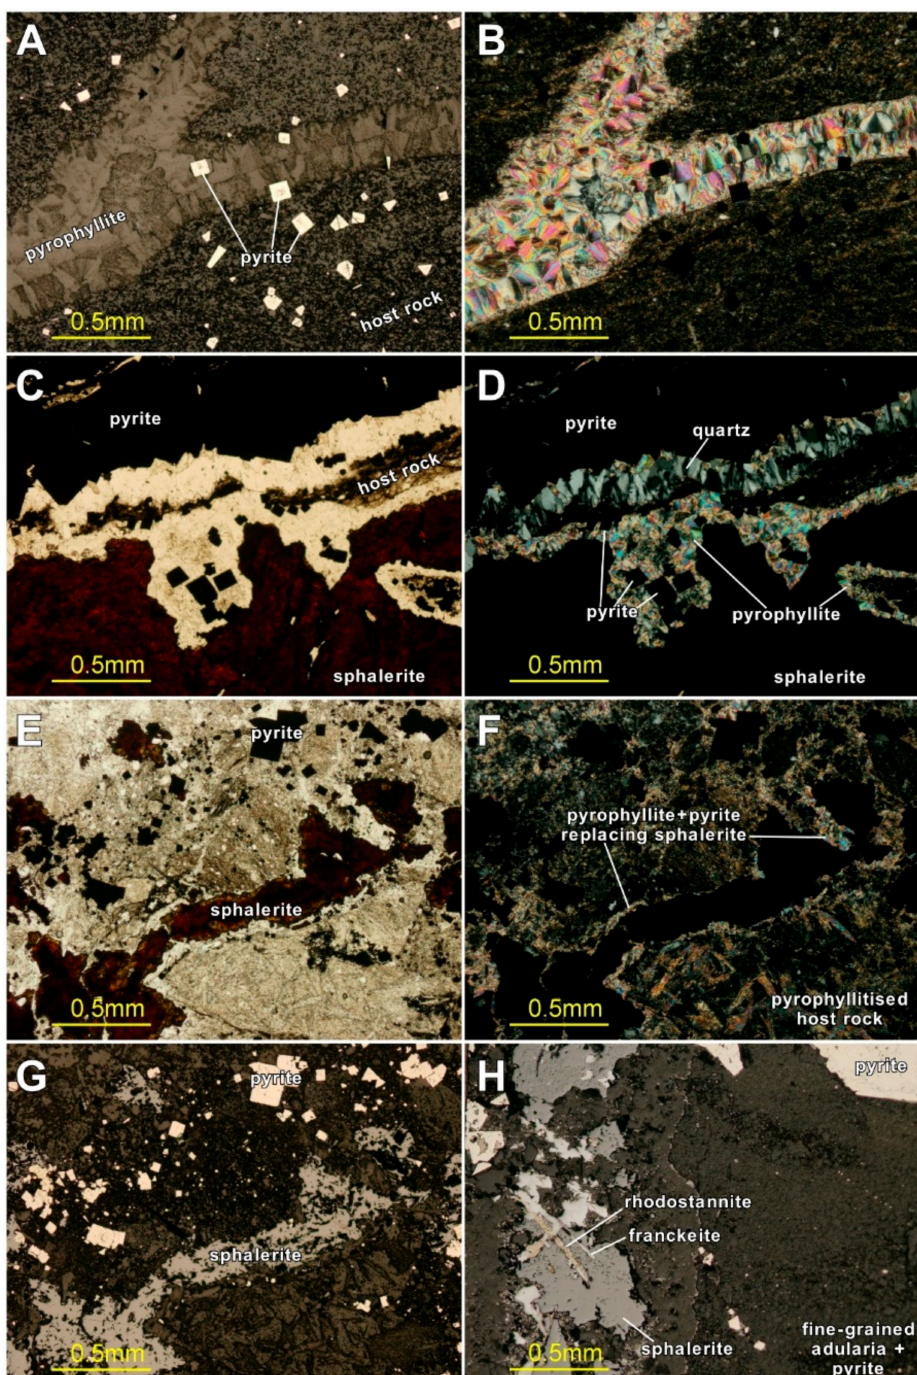
Figure 3. Photomicrographs of diagnostic gangue minerals in the Poop ó deposit. ( A ) Pyrophyllite stringers with pyrite, in pyritised host shales; polarised reflected light. ( B ) Same as A, but under transmitted light and crossed polars. ( C ) Vein material (sphalerite, quartz and pyrite) with later pyrophyllite and pyrite replacing sphalerite; polarised transmitted light. ( D ) Same as C, but crossed polars. ( E ) Sphalerite stringers in host rocks that underwent strong alteration by pyrophyllite, with an association of pyrophyllite and pyrite replacing sphalerite through the stringer rims; polarised transmitted light. ( F ) Same as E, but crossed polars. ( G ) Same as E and F, but under polarised reflected light. ( H ) Association of tin sulphosalts (franckeite and rhodostannite) and sphalerite, cut by a later association of fine-grained adularia and pyrite; polarised reflected